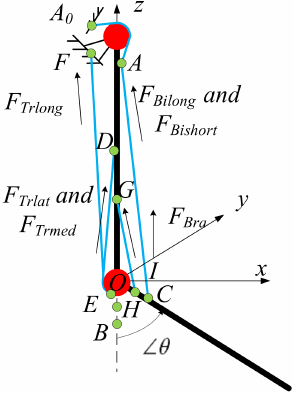
Figure 6. Schematic diagram of improved elbow joint musculoskeletal